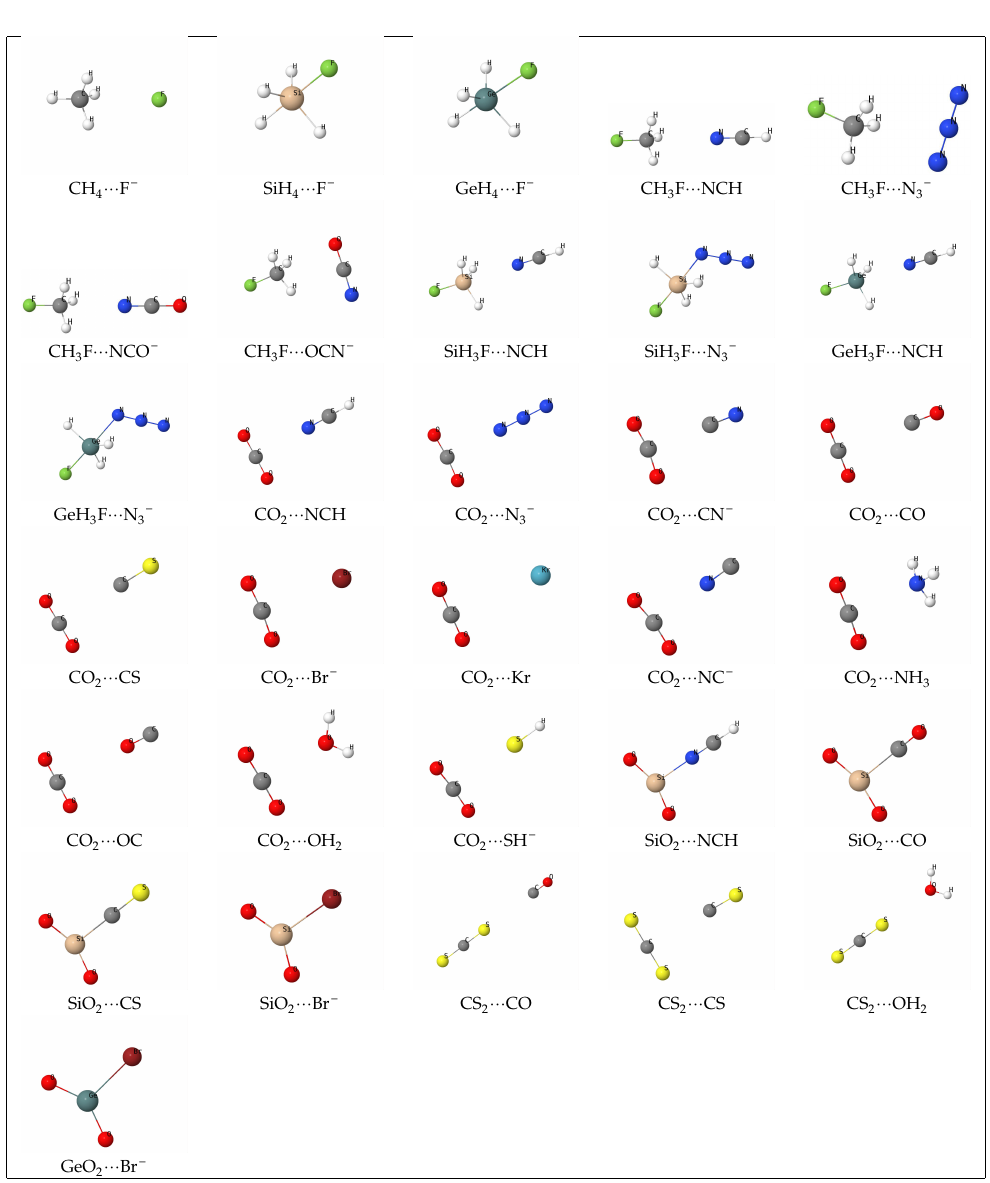
Figure 1. AB complexes studied in this